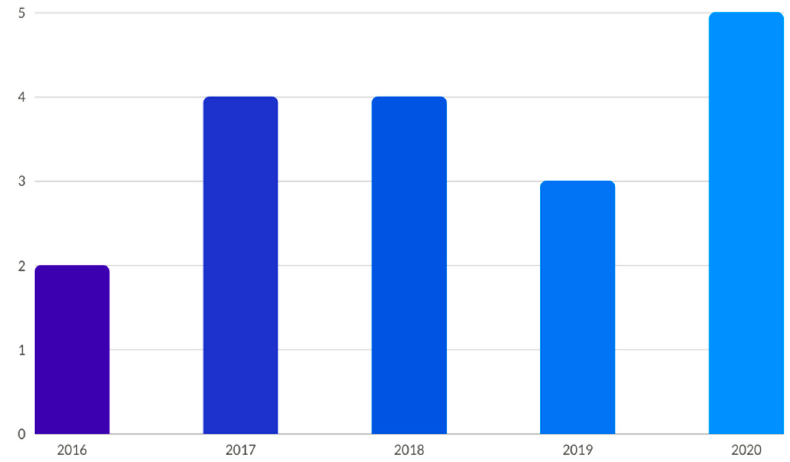
Figure 3. Studies’ publication years.